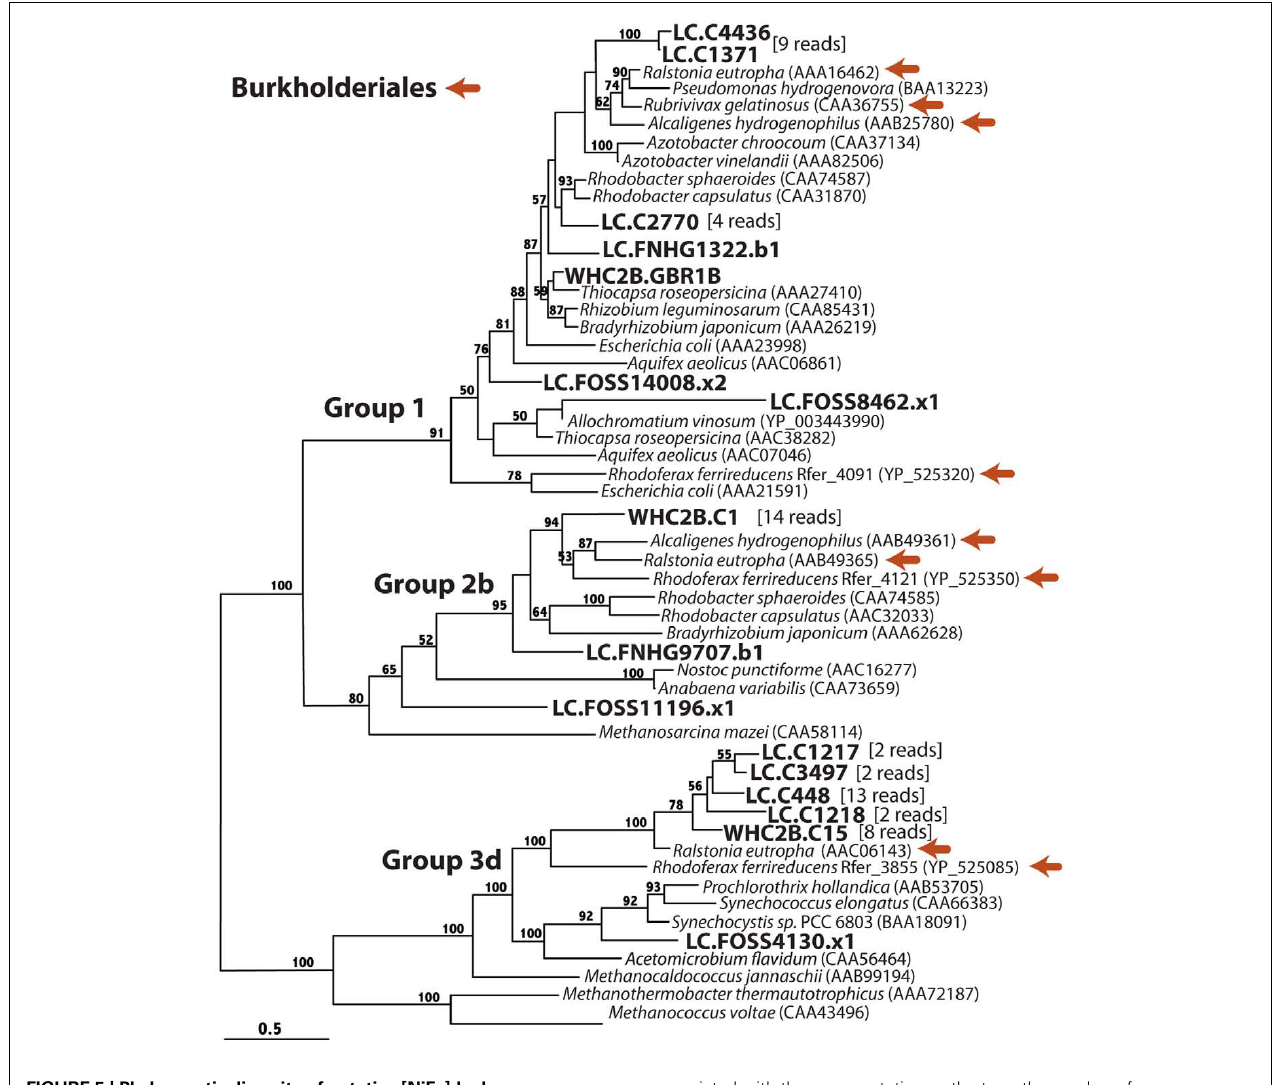
FIGURE 5 | Phylogenetic diversity of putative [NiFe]-hydrogenase detected in metagenomes from a Lost City chimney andTablelands spring fluid. Burkholderiales references sequences are indicated with orange arrows, and Lost City (LC), andTablelands (WHC2b) sequences are in large, bold font. If additional metagenomic sequencing reads are